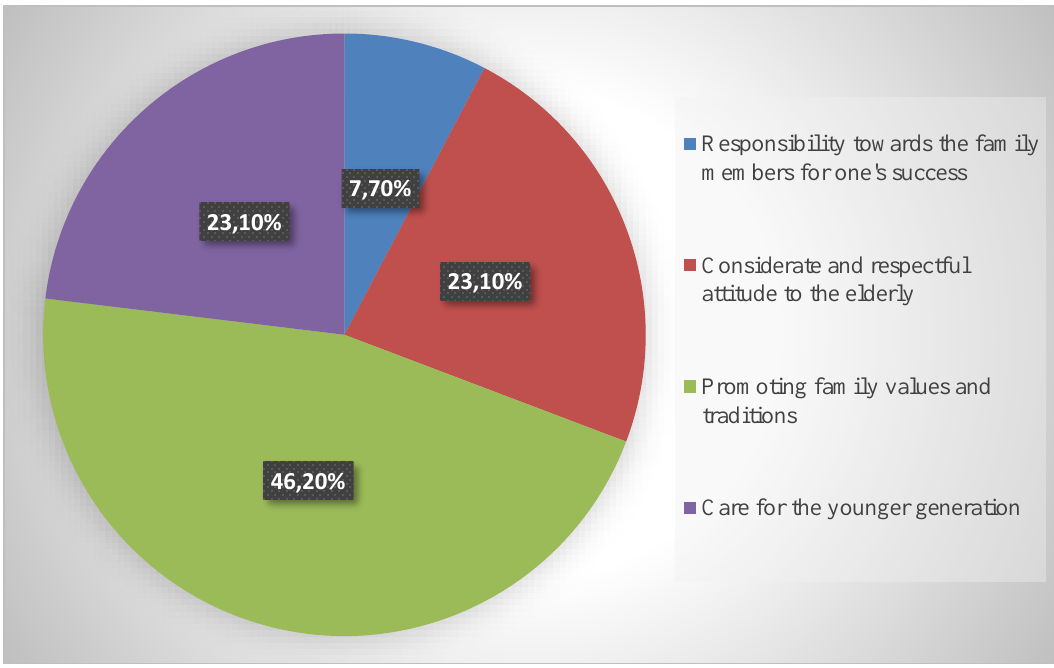
Fig 3. The respondents’ answers about moral values displaying in the textbook